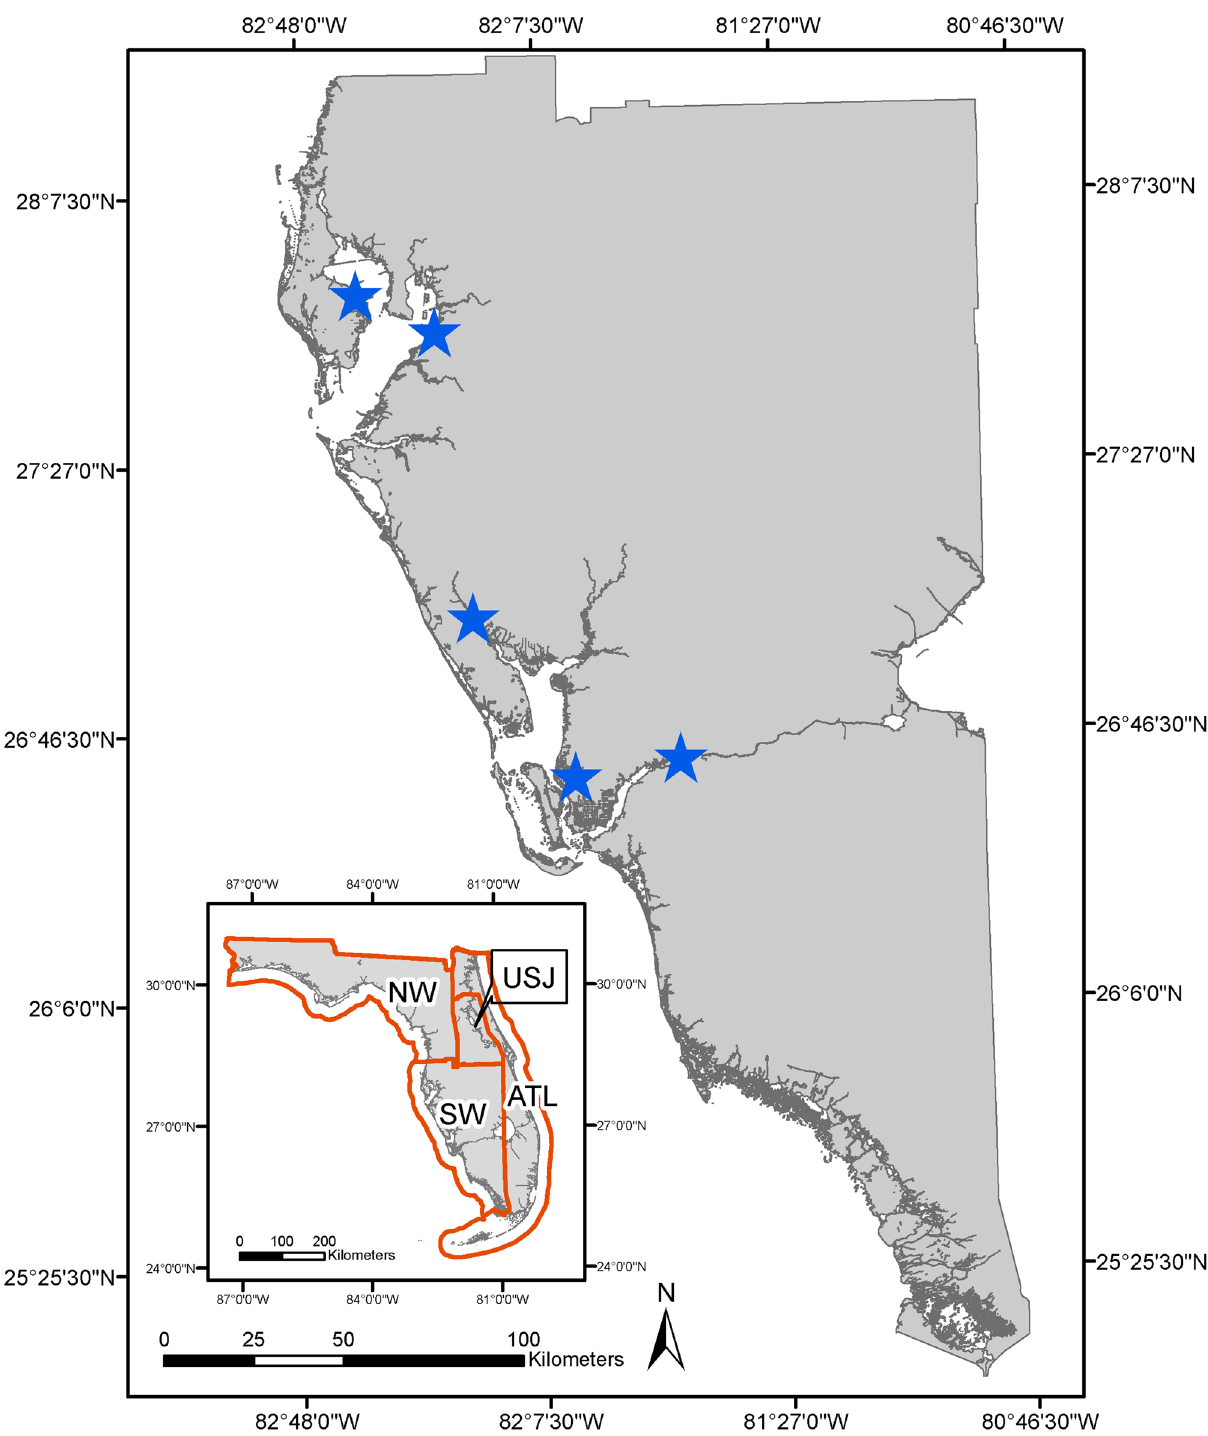
Figure 1. Map of southwest Florida, location of the study population. Florida is divided into four manatee regions or management units (see inset): northwest (NW), southwest (SW), Atlantic coast (ATL), and Upper St. Johns River (USJ). Stars on the map indicate primary locations at which photo-identification data were collected (all are manatee warm-water aggregation sites). Other data streams used in this analysis (carcass data and abundance surveys) were collected throughout potential manatee habitat in southwest Florida and are not pictured. Map generated in ArcMap 10.3 (https:// www. esri.